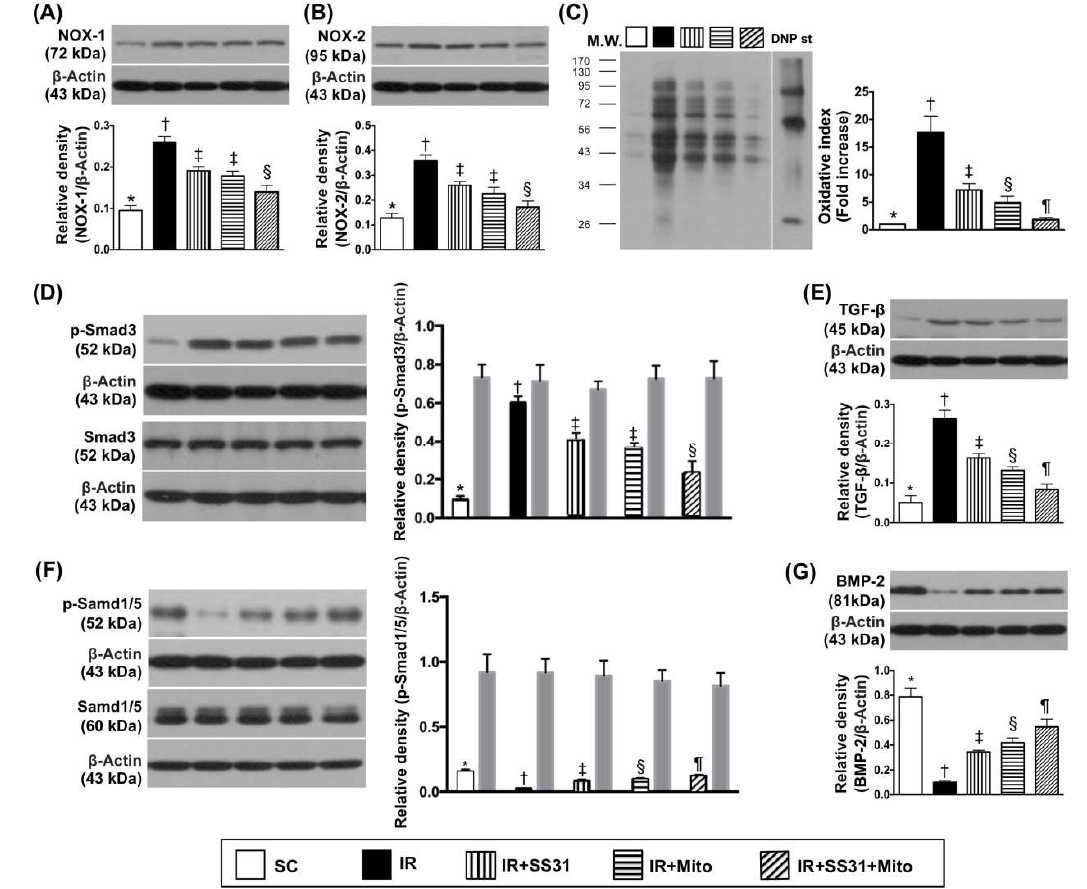
Figure 7. Oxidative-stress biomarkers in LV myocardium after the IR procedure. ( A ) Protein expression of NOX-1 * vs. other groups with different symbols (†, ‡, §), p < 0.0001. ( B ) Protein expression of NOX-2 * vs. other groups with different symbols (†, ‡, §), p < 0.0001. ( C ) Oxidized protein expression * vs. other groups with different symbols (†, ‡, §, ¶), p < 0.0001. (Note: left and right lanes shown on the upper panel represent protein molecular weight marker and control oxidized molecular protein standard, respectively). M.W = molecular weight. DNP = 1-3 dinitrophenylhydrazone. ( D ) Protein expression of phosphorylated (p)-Smad3 * vs. other groups with different symbols (†, ‡, §), p < 0.0001. Protein expression of total Smad3 (i.e., gray-colored bar chart) did not differ among the five groups ( p > 0.5). ( E ) Protein expression of transforming the growth factor (TGF)-ß * vs. other groups with different symbols (†, ‡, §, ¶), p < 0.0001; ( F ) Protein expression of p-Smad1/5, * vs. other groups with different symbols (†, ‡, §, ¶), p < 0.0001. ( G ) Protein expression of bone morphogenetic protein (BMP-2) * vs. other groups with different symbols (†, ‡, §, ¶), p < 0.0001. All statistical analyses were performed by one-way ANOVA, which was followed by the Bonferroni multiple comparison post hoc test ( n = 8 for each group). Symbols (*, †, ‡, §, ¶) indicate significance at the 0.05 level. SC = sham control, IR = ischemia-reperfusion, and Mito = mitochondria.